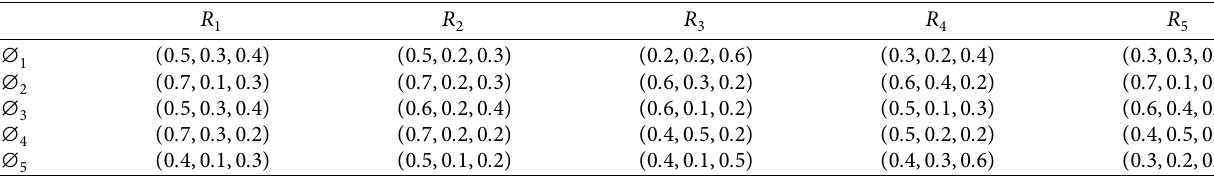
Table 2: Normalized expert data.